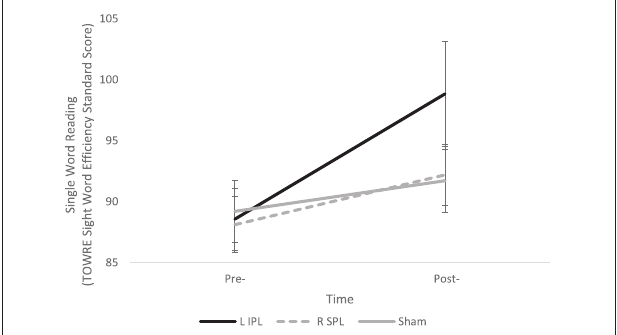
FIGURE 1 | Change in Single Word Reading Efficiency pre- and post-stimulation for each group. A significant Group × Time interaction indicates the L IPL group showed significantly greater improvement than the R SPL and Sham groups. Error bars indicate one standard